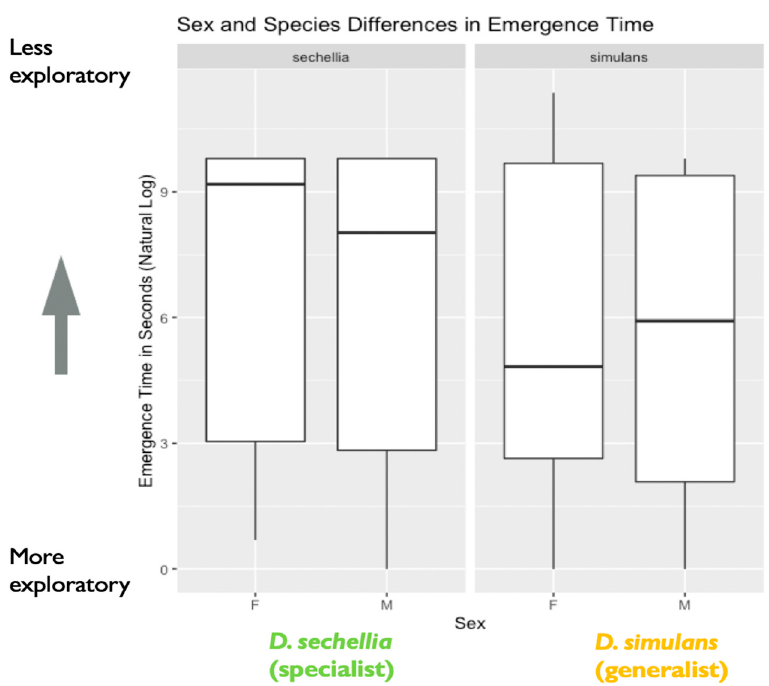
Figure 2. Sex and species di ff erences in emergence time (in seconds): the plot represents species and sex di ff erences in emergence time (in seconds), as noted in the main text. Data are from the first experiment measuring exploratory behavior as a mechanism for environmental sampling. The y-axis represents the natural log of emergence time in seconds. A lower emergence time indicates higher exploratory behavior, while a higher emergence time represents lower exploratory behavior ( n = 526 flies). The box in the plot represents the inter-quartile range of scores, including the middle 50% of scores for the group, with the median score represented by the middle quartile mark (or line). The whiskers represent the score ranges outside the inter-quartile range, including the top 25% of scores for the group in the upper whisker, and the bottom 25% of scores in the lower whisker. Our findings indicated significant sex, but not species, di ff erences in exploratory behavior, with males showing significantly shorter emergence time than females.